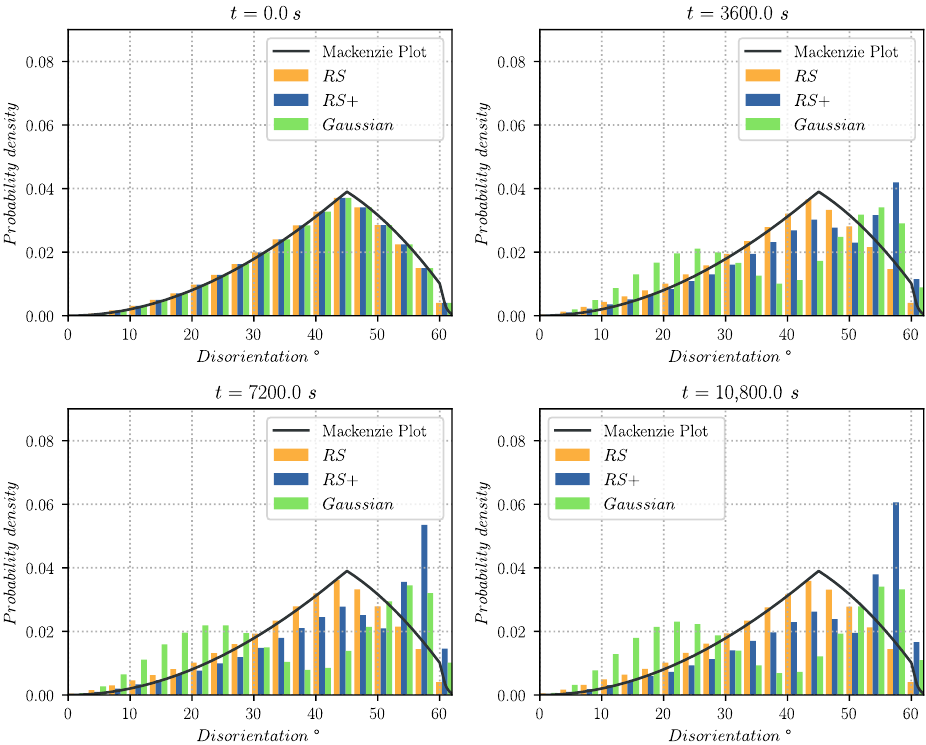
Figure 10. Probability density plot of the disorientation angle weighted by GB length, for the cases using the Gaussian, RS, and RS+ functions for the computation of the GB energy γ , and for different times. Each class of data contains the results of four different initial states representative of the same initial grain size